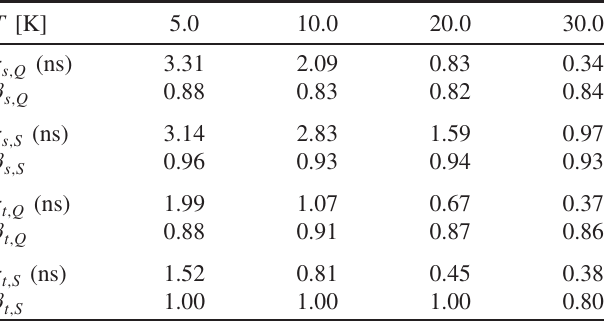
TABLE II. Relaxation time τ and stretching parameter β as obtained by fitting the calculated time dependence of the order t Þ of the weakly disordered square ensemble and parameters η MV ð η t Þ of the weakly disordered triangular ensemble at different FM ð temperatures T [see Eq. (18)]. The first index s ( t ) refers to the square (triangular) lattice, while the second index Q ( S ) denotes the relaxation after quenching (saturation). The standard devia- tions of the fits are very small, in the range 10 − 5 – 10 − 3 .